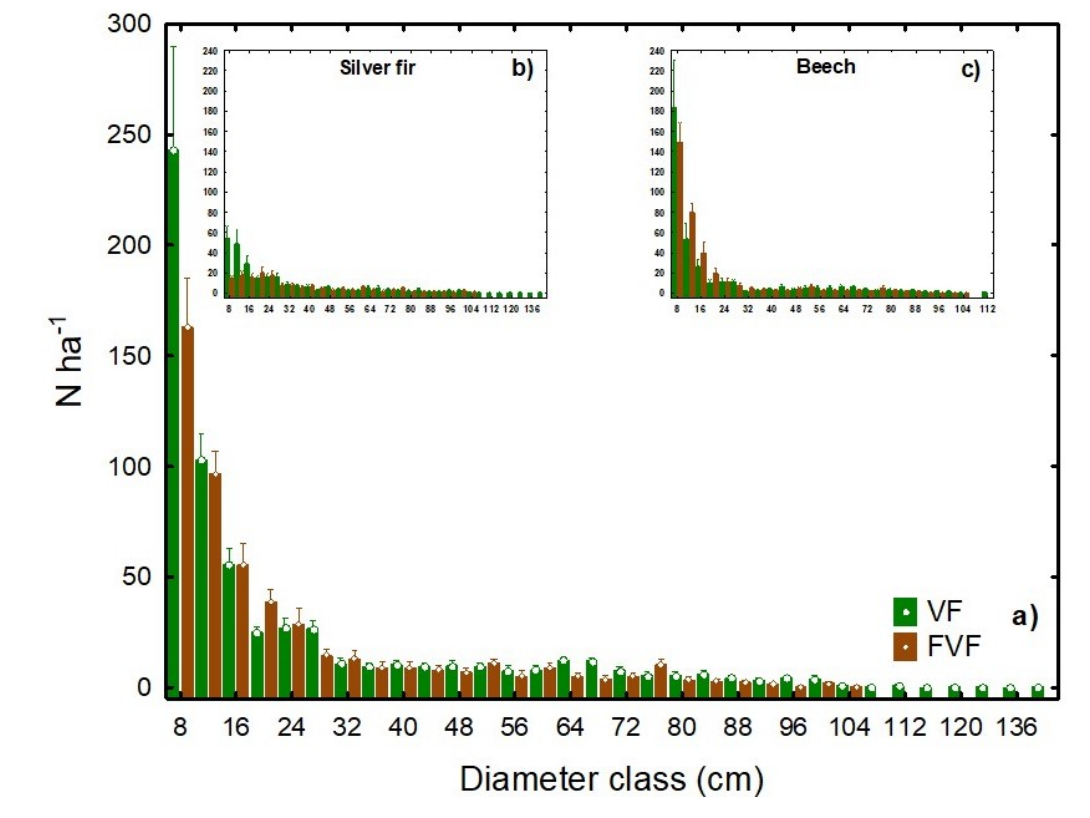
Figure 2. The distribution of the number of trees per diameter class in VF and in FVF ( a ) independent of species and separately for the two main species (( b )—Silver fi r and ( c )—Beech).